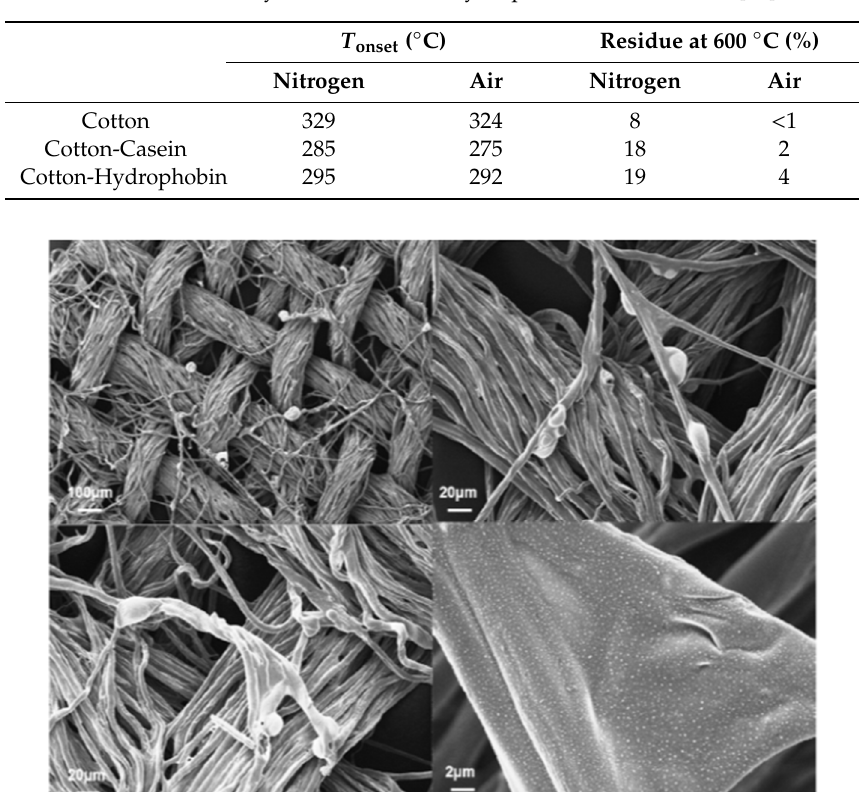
Table 3. TGA analysis for casein and hydrophobin-treaded cotton [36].